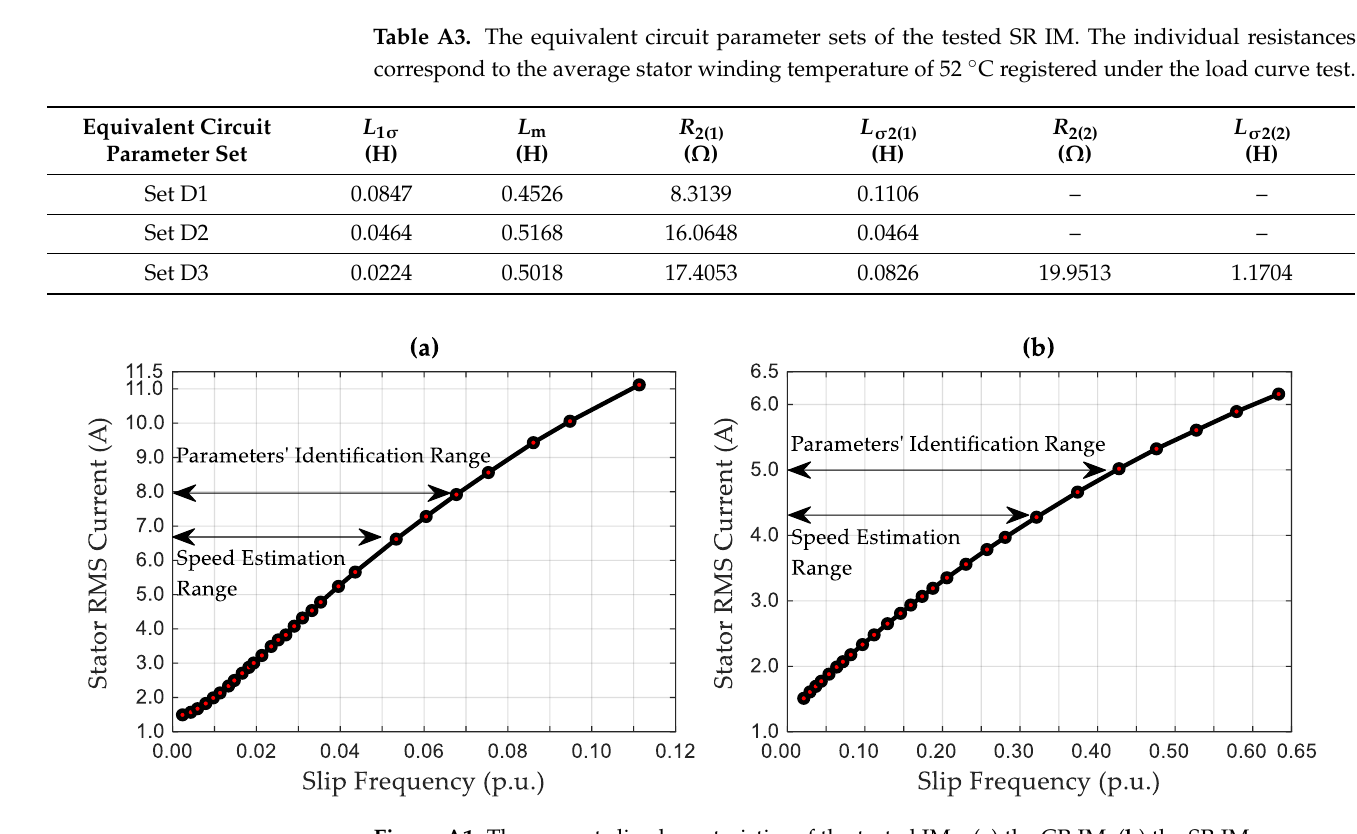
Figure A2. A schematic diagram and picture of the laboratory test bench: 1 — tested IM; 2 — programmable AC source AMETEK 3001iX; 3 — programmable electronic load ZSAC4244; 4 — DAQ. Appendix C Figures A3 and A4 present the components of the adaptation mechanism functions in the synchronous rotating frame returned by the selected configurations of the MRAS-based speed estimators together with the speed estimates included in the main text of the paper.